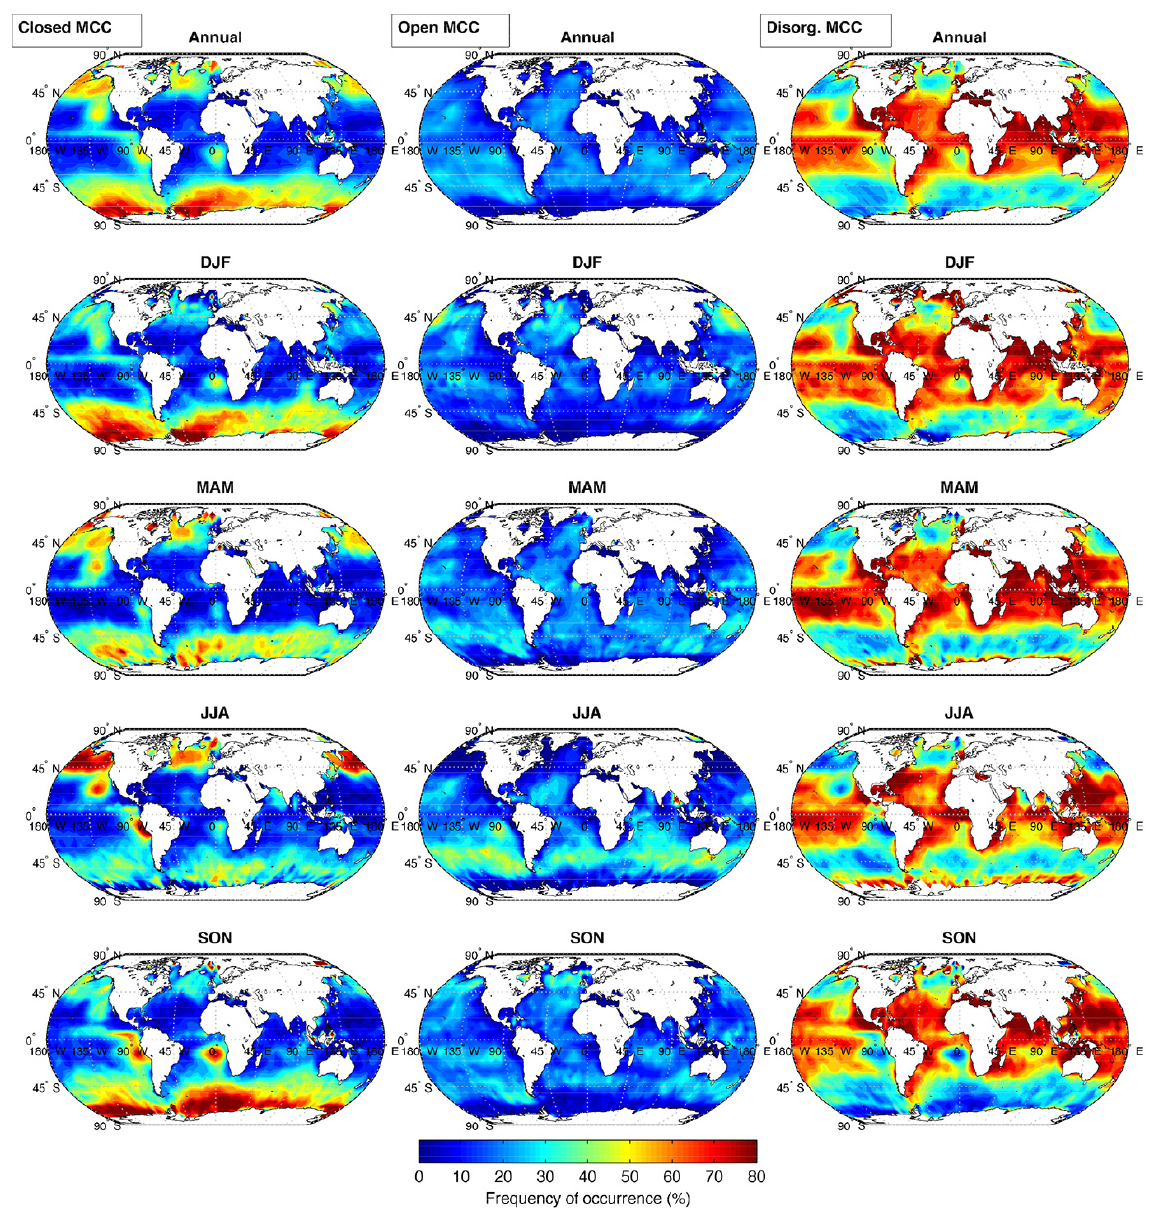
Figure 5. Global distribution of the frequency of occurrence of MCC types based on 1 year of MODIS Aqua observations from 2008. Shown are closed MCC (left), open MCC (center) and cellular but disorganized MCC (right). Seasonal means are shown for winter (DJF), spring (MAM), summer (JJA) and fall (SON). All MCC observations are binned into 5 ◦ × 5 ◦ regions. The frequency of occurrence is the fraction of occurrences of a certain MCC type to the total number of all MCC occurrences expressed as a percentage value. Regions with no data are shown in